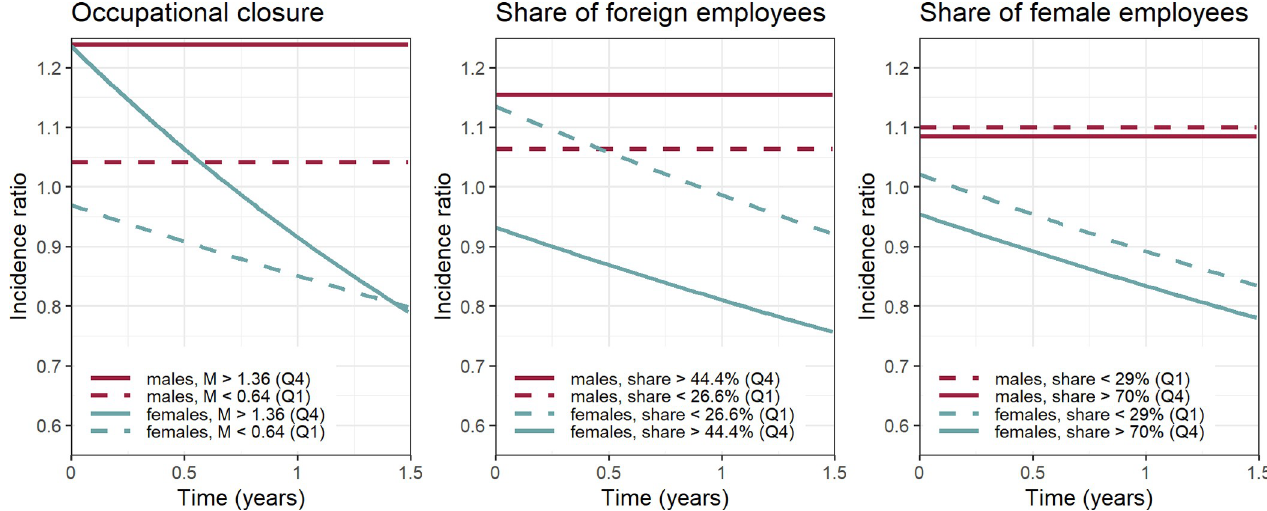
Fig 2. Gendered occupational effects on the employment incidence. Source: LMDB. Predicted from stratified cox proportional hazards model M3 (see Table 1), time to first employment spell of at least 91 days. Covariates were held constant at the following values: 21-24 years of age, in the country for 14 years or longer, marital status single, lower secondary education credential, more than 180 days of work experience in 2013, and median values for other structural variables.